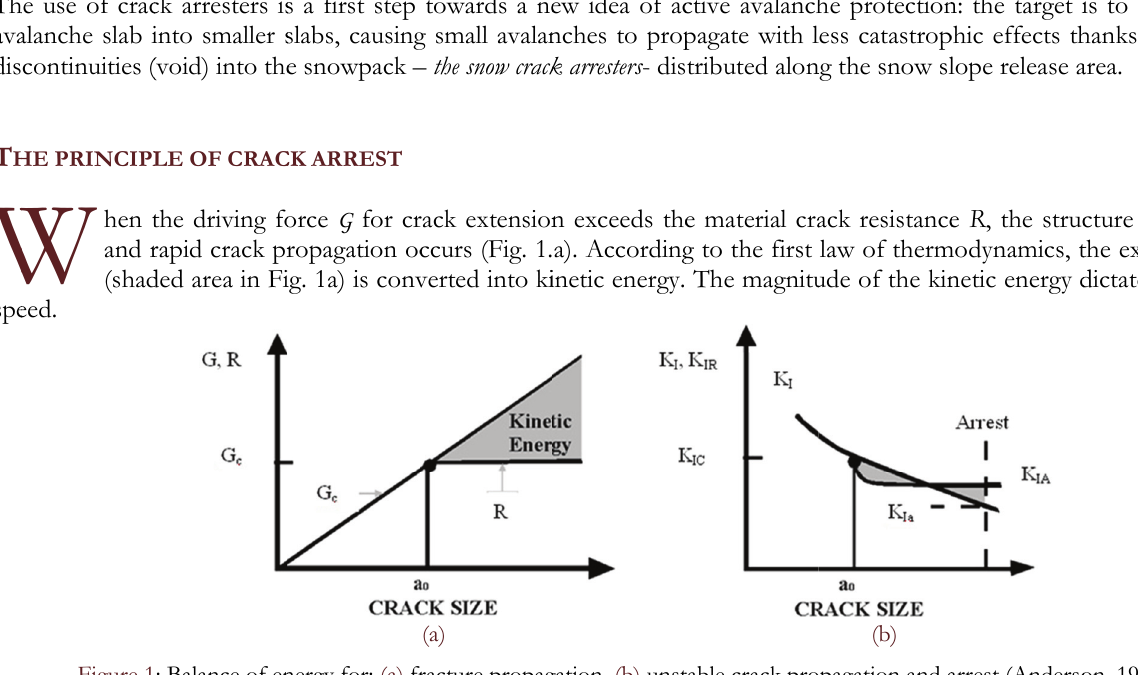
a quasi-static ack arrests.